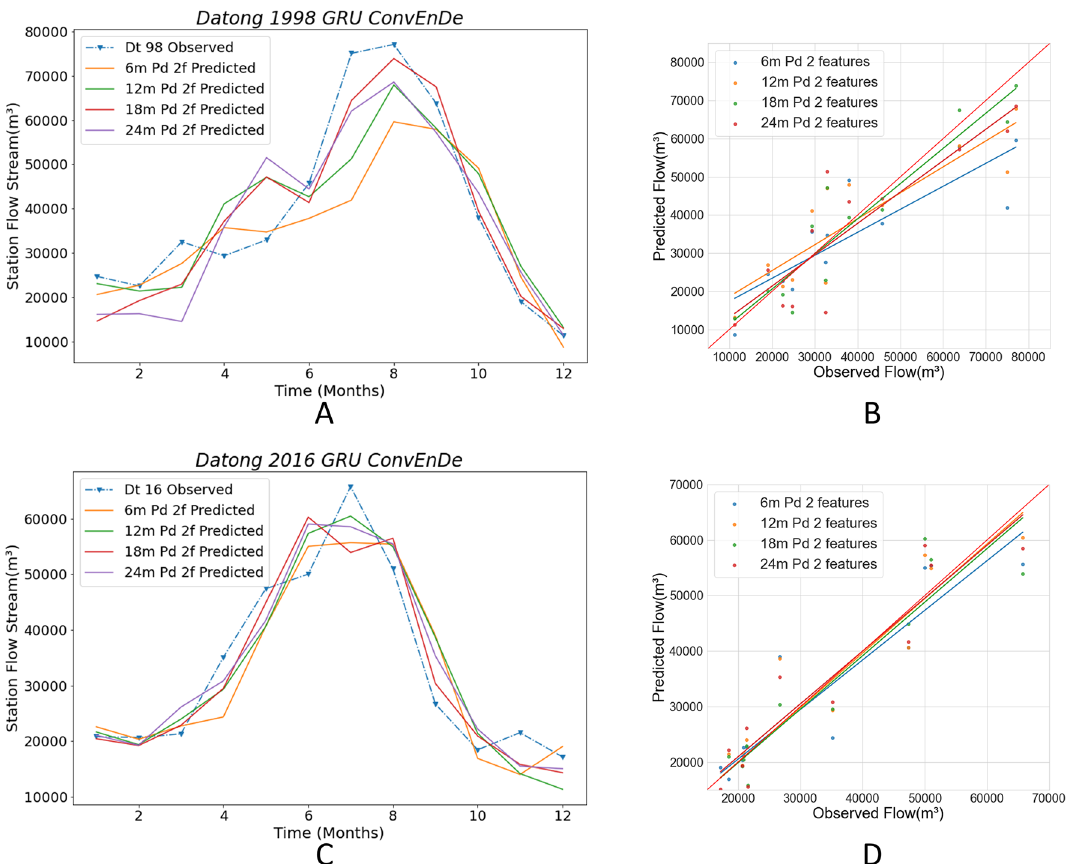
Figure 13. Comparison among the Conv encoder–decoder GRU with different periods in Datong station. The solid lines in A, C plot the predicted values using different periods of data, and the blue dashed lines are the observed values. ( B, D ) Scatter plots of predicted and observed values for the four periods of data.